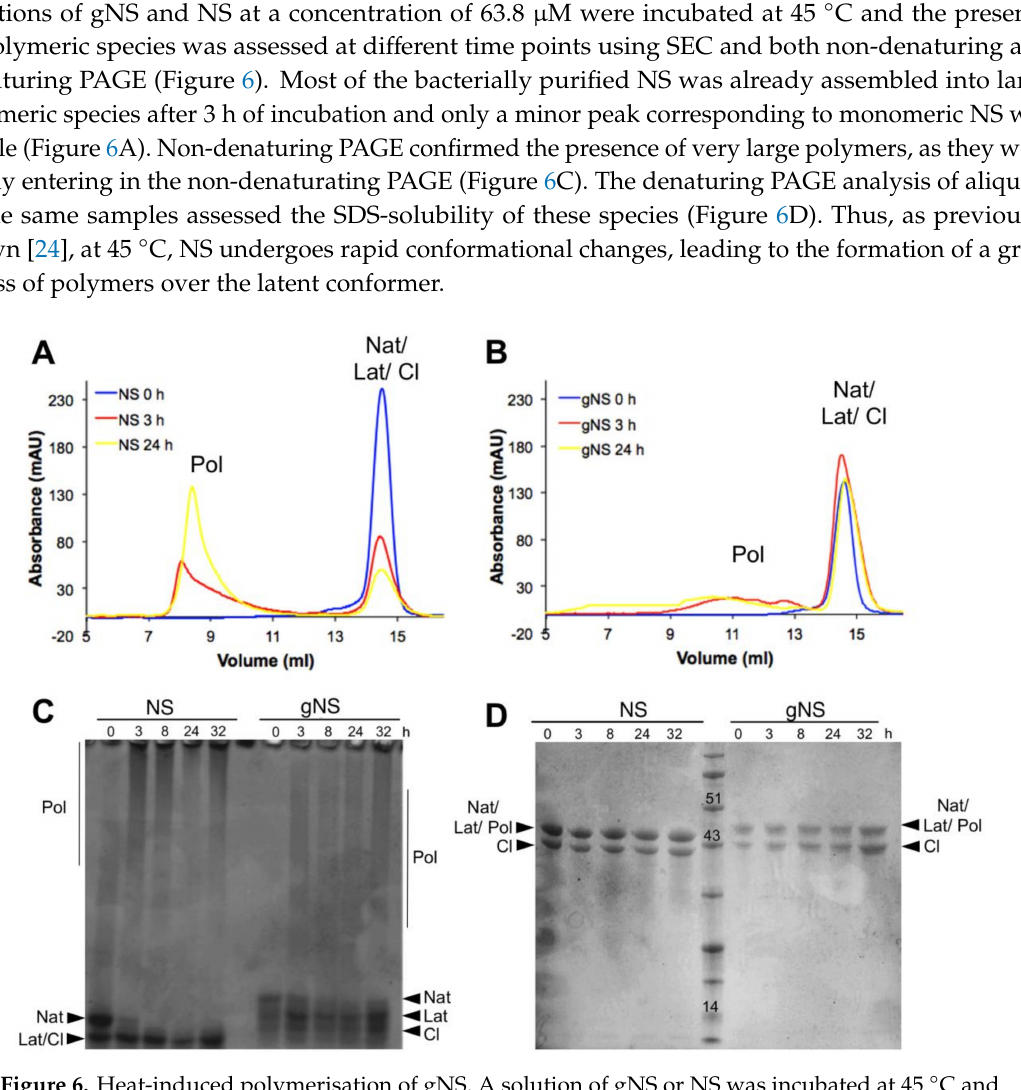
Figure 6. Heat-induced polymerisation of gNS. A solution of gNS or NS was incubated at 45 ◦ C and analysed at di ff erent time points. SEC analysis of NS ( A ) or gNS ( B ) using an Increase Superdex 200 column. Aliquots of NS or gNS were analysed by non-denaturing ( C ) and denaturing ( D ) PAGE. Abbreviations: Nat: native; Cl: cleaved; Lat: latent; Pol: